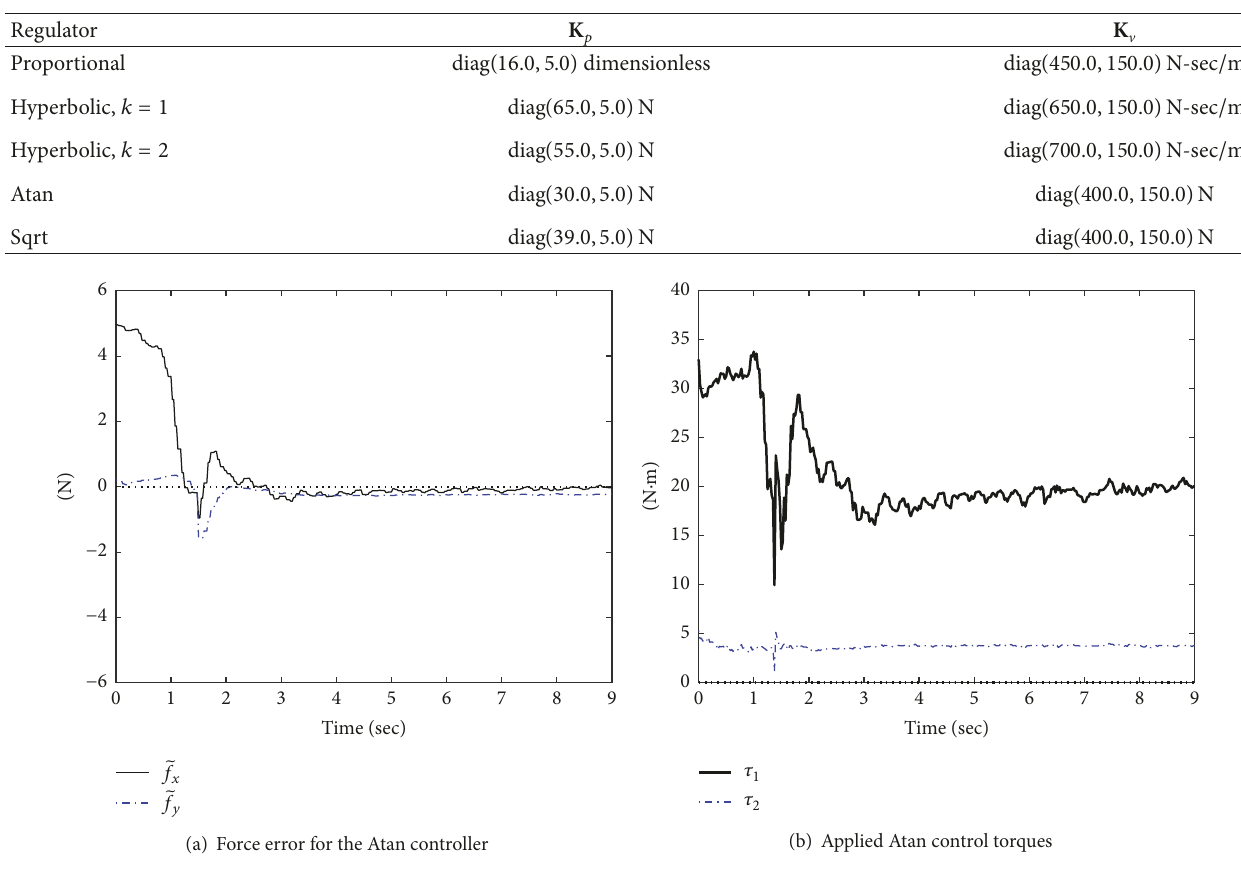
Table 2: Gain matrices K 𝑝 and K V for the force regulators.